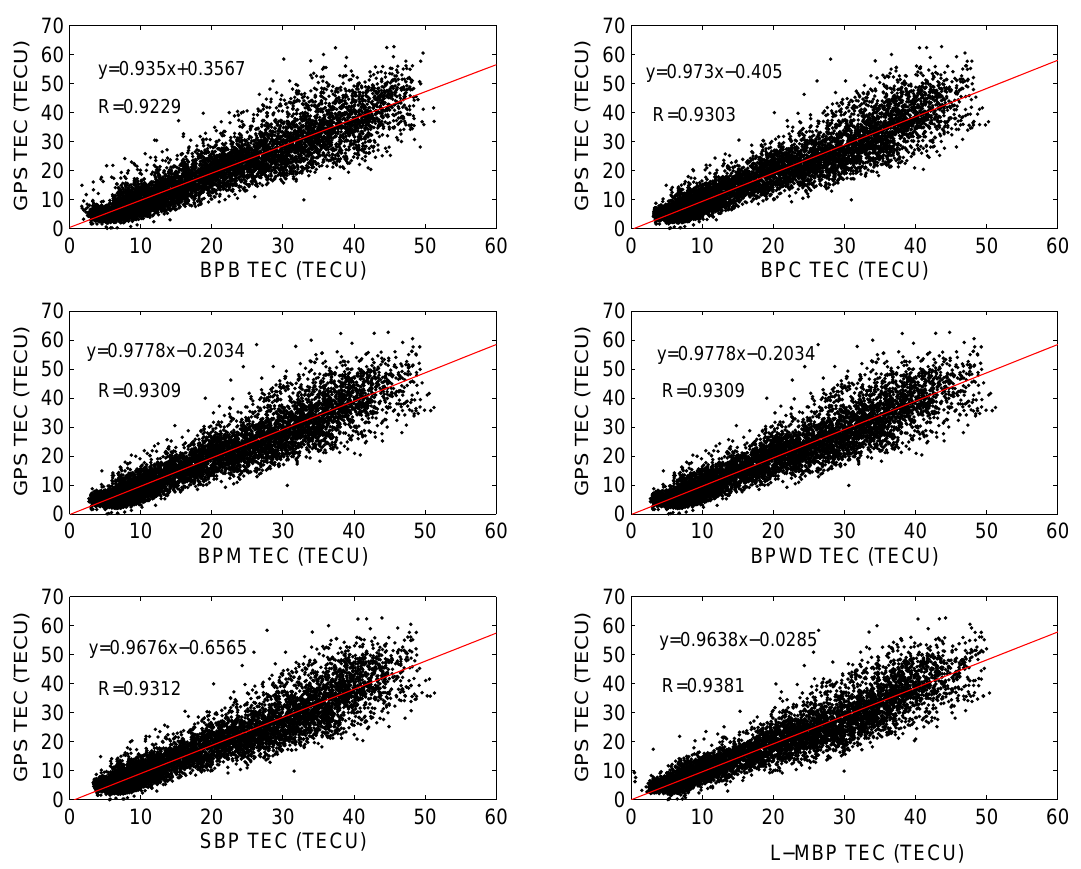
Fig. 1. Scatter plots for hourly GPS TEC and corresponding modelled TEC values using different NN training algorithms for Sutherland in 2003.